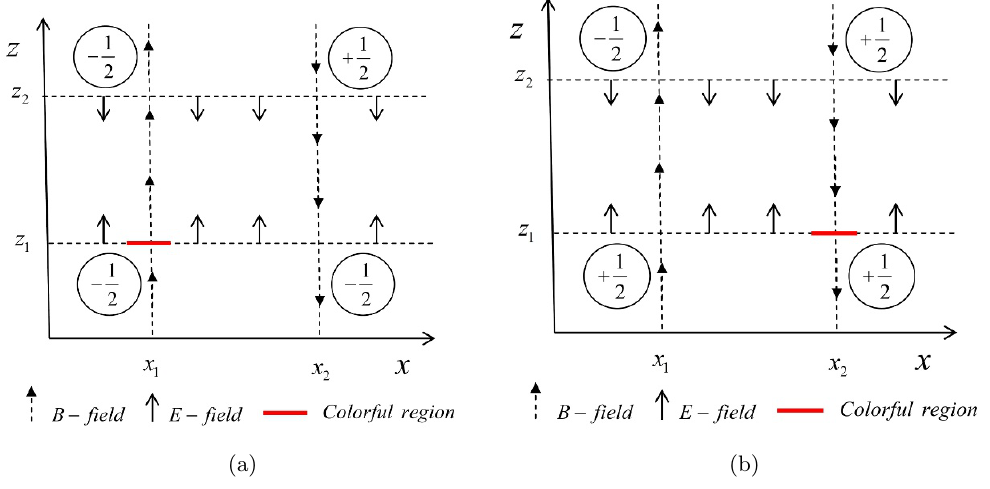
Figure 3 . The geometry, (cid:12)eld strength and the contribution to the topological charge of the intersection regions in the intersection plane of two anti-parallel vortex pairs. In diagram (a) the red line at the intersection point ( x 1 ; z 1 ) indicates that the uni-color vortex is in this region substituted by a colorful region. In the right diagram (b) the region around ( x 2 ; z 1 ) is